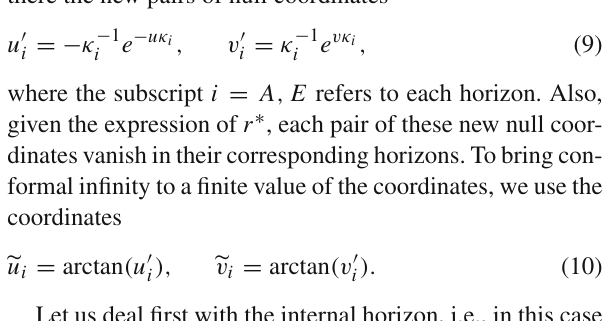
Fig. 1 Different structures for accelerating black holes as a function of acceleration. The vertical and horizontal axes represent r cos θ and r sin θ , respectively. The north semiaxis corresponds to θ = 0 and the south semiaxis to θ = π . The thick (green) line is the conformal infin- ity reached for finite and positive r , the dashed (orange) line gives the